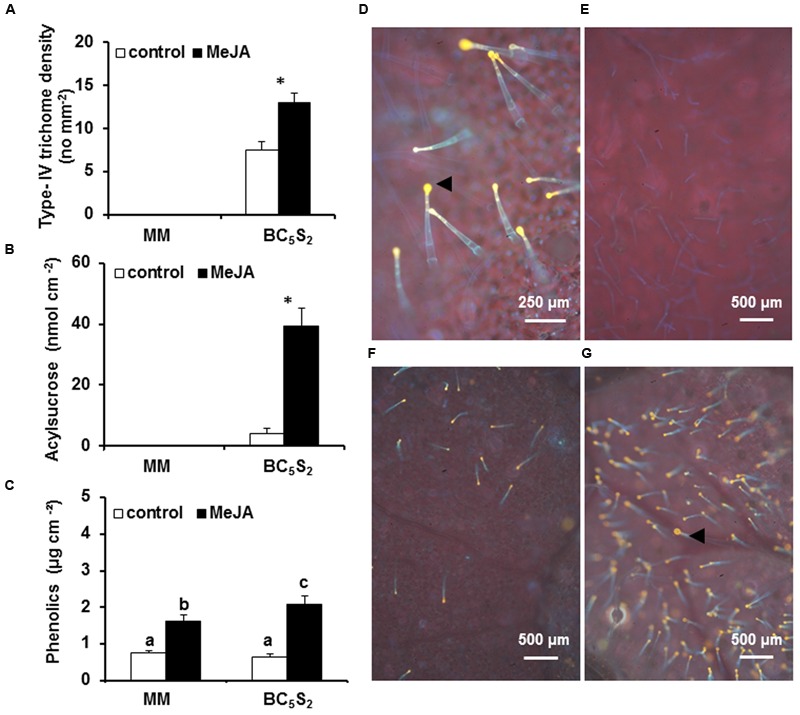
Effect of multiple methyl jasmonate (MeJA) applications on type-IV glandular trichome density and targeted secretions at 21 days after the initial hormone induction in BC5S2 and ‘Moneymaker’ (MM). Two independent experiments were performed. Representative data from one experiment are shown. (A) Mean values + SEM (n = 12–15) of type-IV glandular trichome densities measured in mock- and MeJA-treated plants. (B) Mean values + SEM (n = 15) of acylsucrose secretions in mock-treated and MeJA-treated MM and BC5S2 plants. Significant differences between treatments in BC5S2 plants were tested by t-test. Asterisks denote significant differences at P ≤ 0.001. (C) Mean values + SEM (n = 15) of phenolic content in leaf exudates of mock-treated and MeJA-treated MM and BC5S2 plants. Bars with different letters indicate significant differences among groups compared by Fisher’s least significant differences (LSD) test at P ≤ 0.05. Representative micrographs of phenolics accumulation in diphenylboric acid-2-aminoethyl ester (DPBA)-flavonoid stained abaxial leaf surfaces of mock-treated (D,F) and MeJA-treated (G) BC5S2 plants. Black arrows point golden fluorescence associated to the presence of phenolic compounds in the glands of type-IV trichomes of BC5S2 plants. (E) Absence of type-IV trichomes and gold fluorescence was observed in DPBA-treated abaxial leaf surfaces of MeJA-treated MM plants.